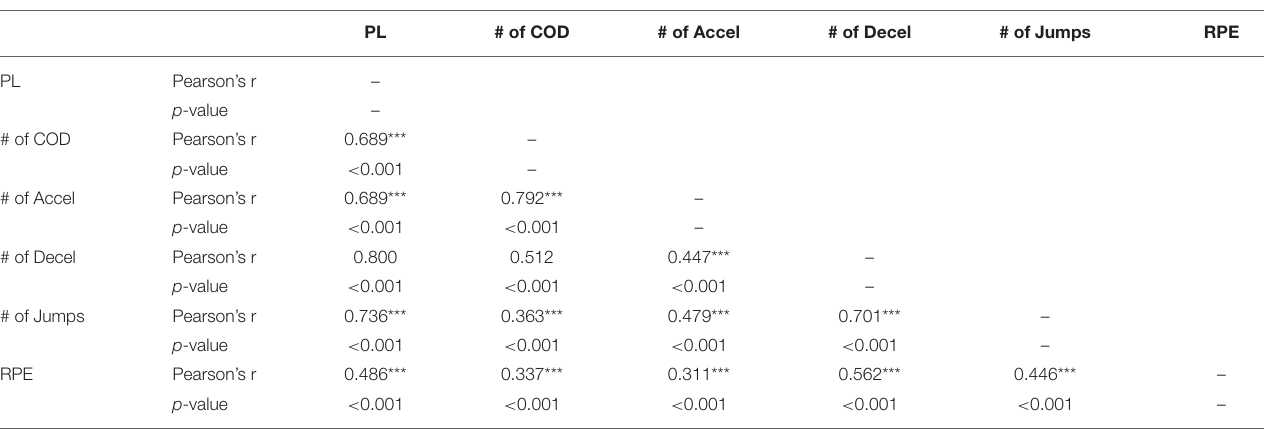
TABLE 3 | Correlation matrix between accelerometer variables and